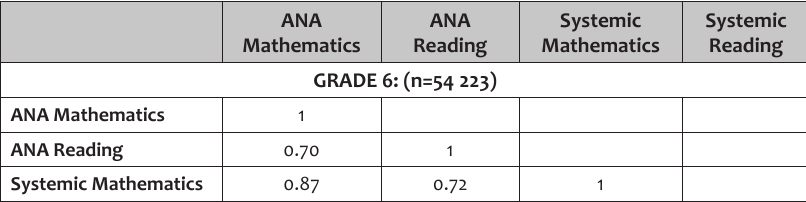
Table 2: Correlations between ANA test scores and Western Cape Systemic Evaluation scores in mathematics and reading in Grades 6 and 9, 2012 (Source: Own calculations from ANA and Western Cape Systemic Evaluation